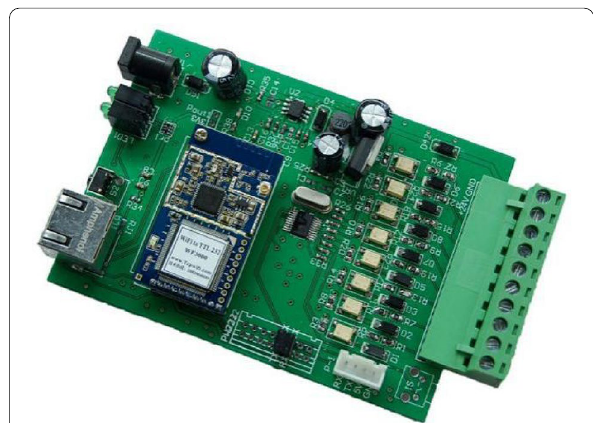
Figure 3 Diagram of a